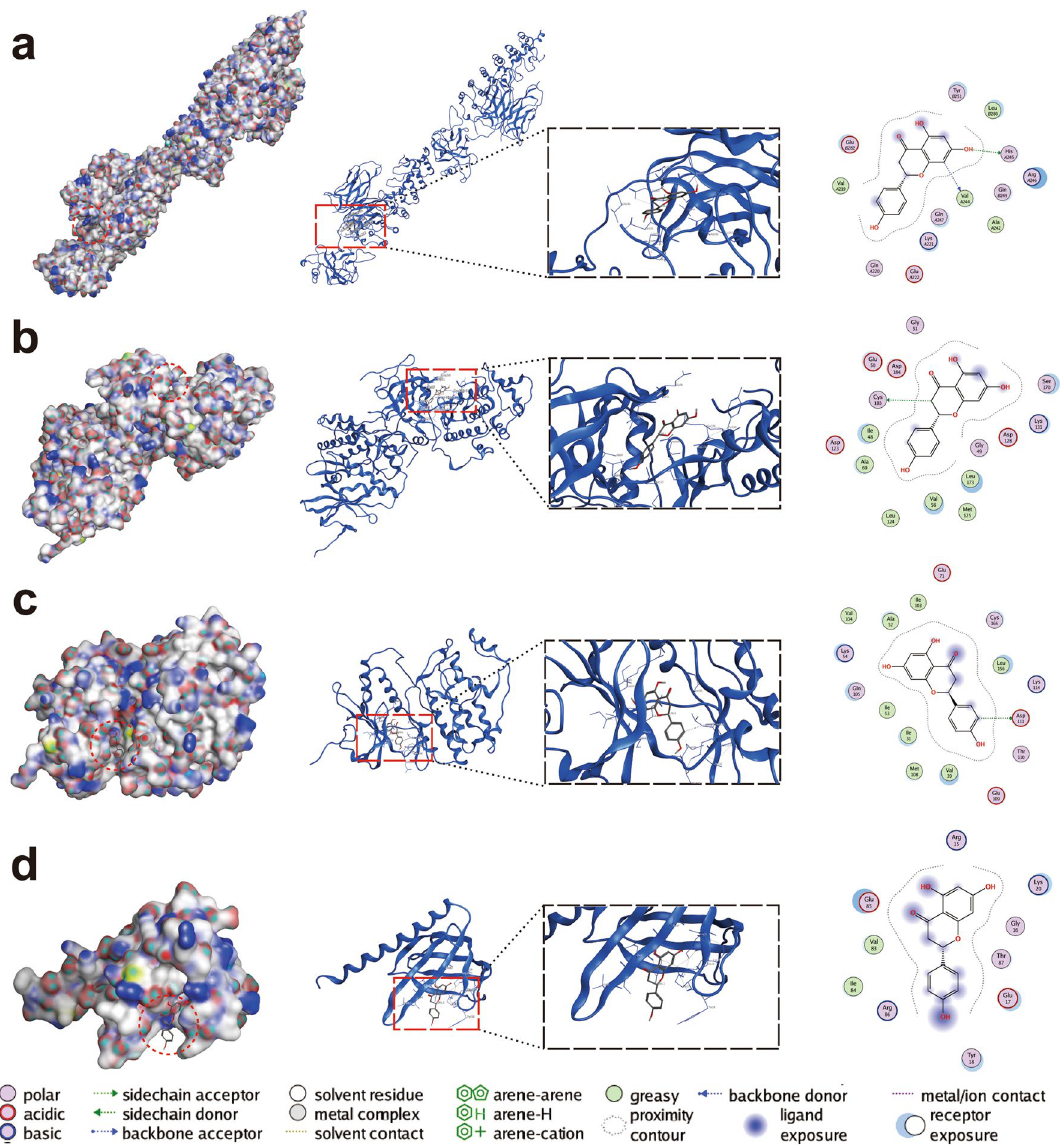
Figure 4. Molecular docking of the key targets that bind to naringenin. The binding poses of naringenin with ( a ) RELA, ( b ) MAPK3, ( c ) MAPK1 and ( d ) AKT1 are